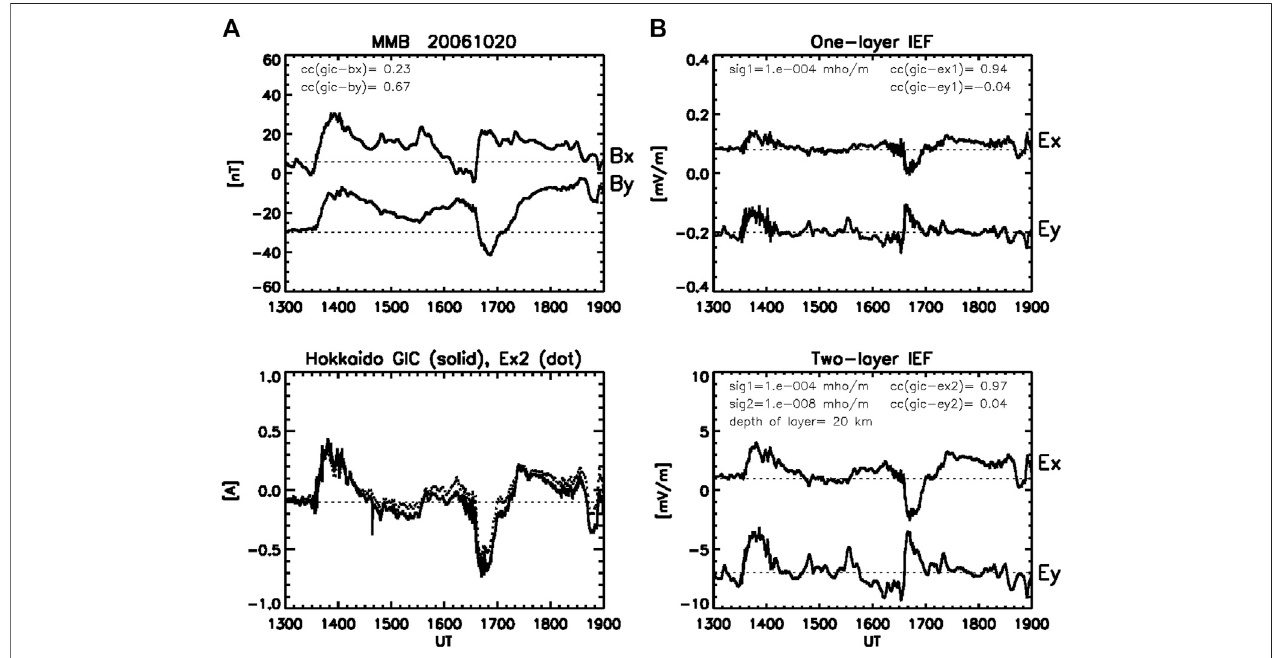
FIGURE 4 | (A) B x , B y and GIC observed at MMB, and (B) E x and E y calculated in the one- and two-layer models for the substorm positive bay events with time scales of 60 min in the pre-midnight (14 UT, 23 MLT) and post-midnight (17 UT, 02 MLT). The parameters and formats of the plots are the same as in Figure 1